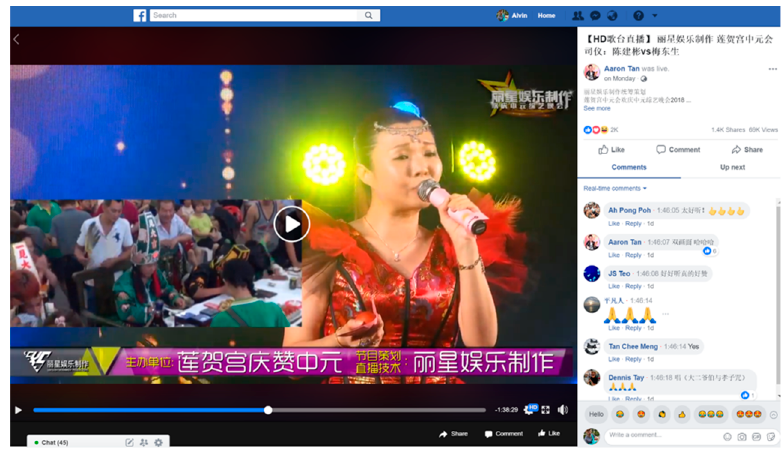
Figure 2. “HD Getai Live Broadcast”, posted by Aaron Tan on 3 September 2018 during the Hungry Ghosts Month 1 . Source: Facebook.